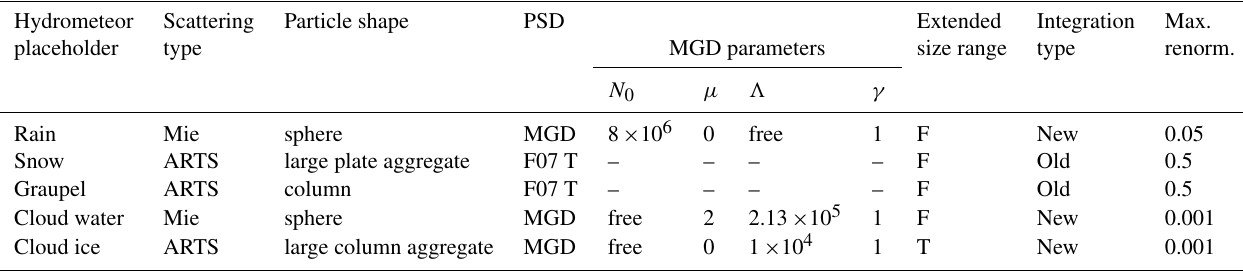
Table 1. Default five-hydrometeor settings. Hydrometeor Scattering